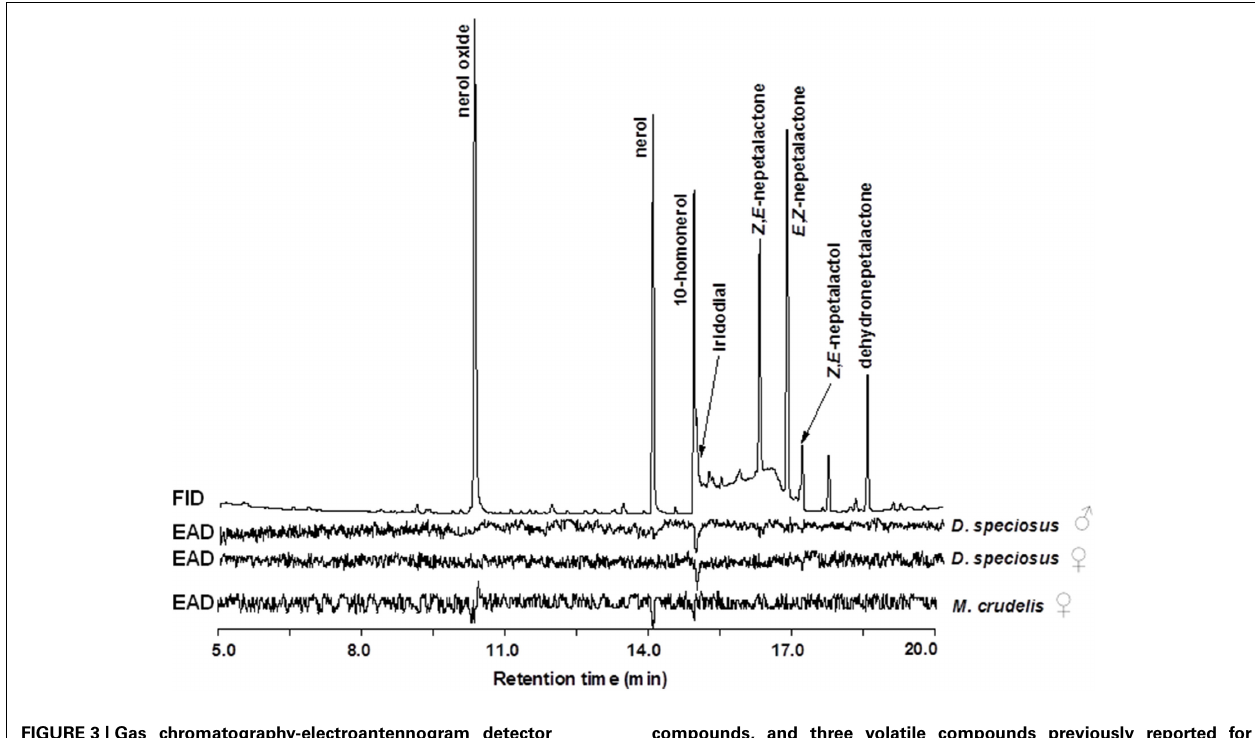
FIGURE 3 | Gas chromatography-electroantennogram detector (GC-EAD) responses of Dendroleon speciosus and Myrmeleon crudelis to a mixture of synthetic green lacewing related